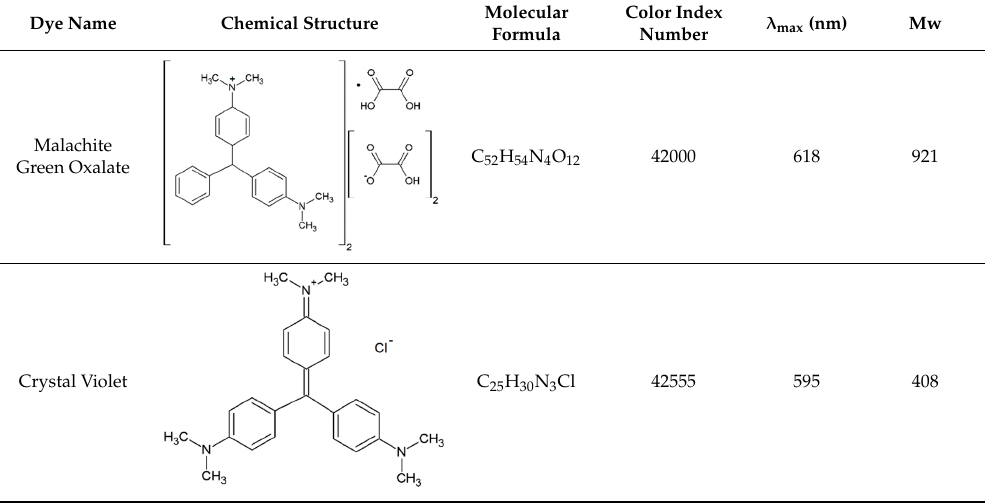
Table 1. Molecular structures of the malachite green and crystal violet dyes.